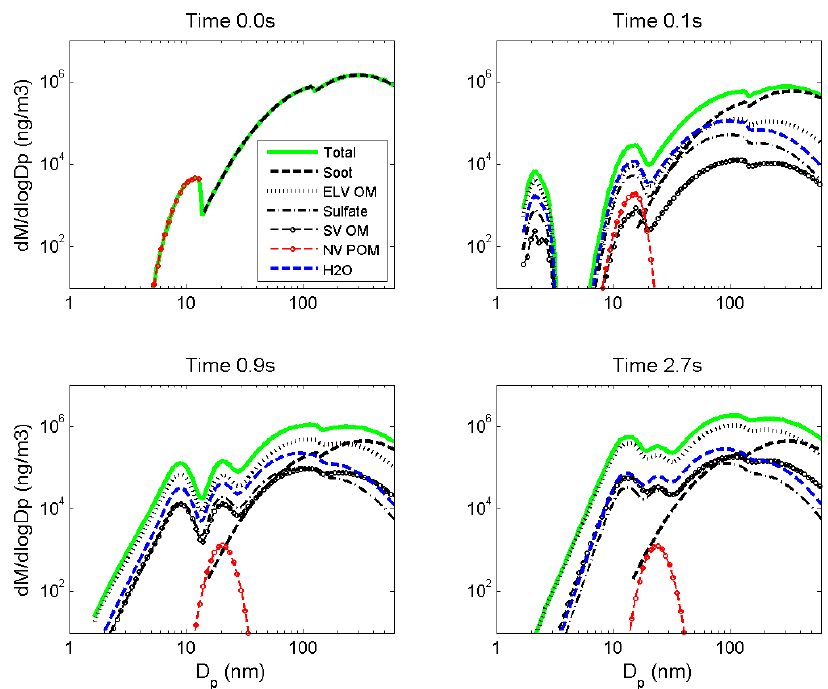
Figure 8. Mass composition distribution (d M/ dlog D p in ngm − 3 ) at different stages of the exhaust (initial at t = 0.0s, after dilution t = 0.1s, in the ageing chamber t = 0.9s, and final t = 2.7s) modelled by MAFOR. Includes the total mass concentration (green line) and the mass distributions of non-volatile organic matter (OM nv , red dashed line with open circles), soot (black dashed line), sulfuric acid (black dash- dotted line), semi-volatile organic matter (OM s , black dashed line with open circles), extremely low-volatile organic matter (OM l ) as well as the mass distribution of water (blue dashed line). The nucleation mechanism for these simulations was HET.